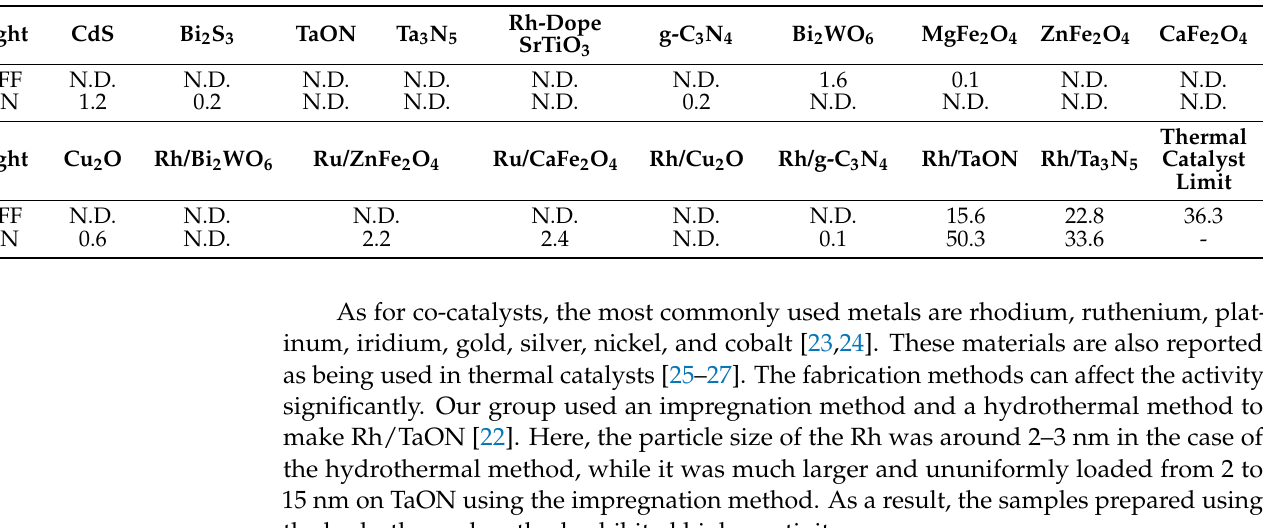
Table 1. H 2 yield (%) over visible-light-sensitive catalysts with and without visible light irradiation at 450 ◦ C. N.D. = not detected. Reproduced from [22] with permission from The Royal Society of